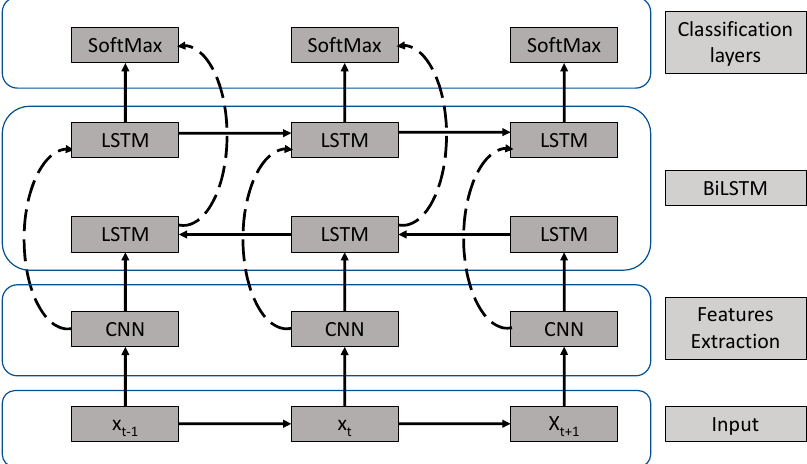
Figure 5. Structure of CNN-BiLSTM.